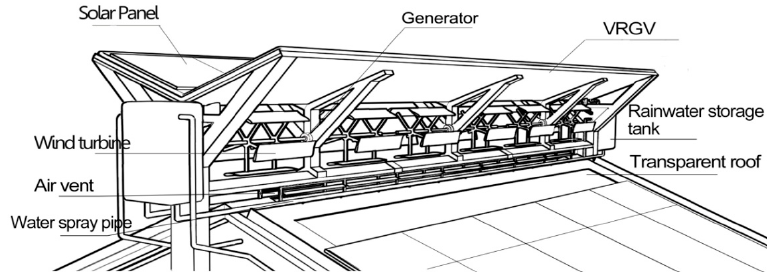
Figure 13. Wind energy system of the hybrid renewable energy harvester system.